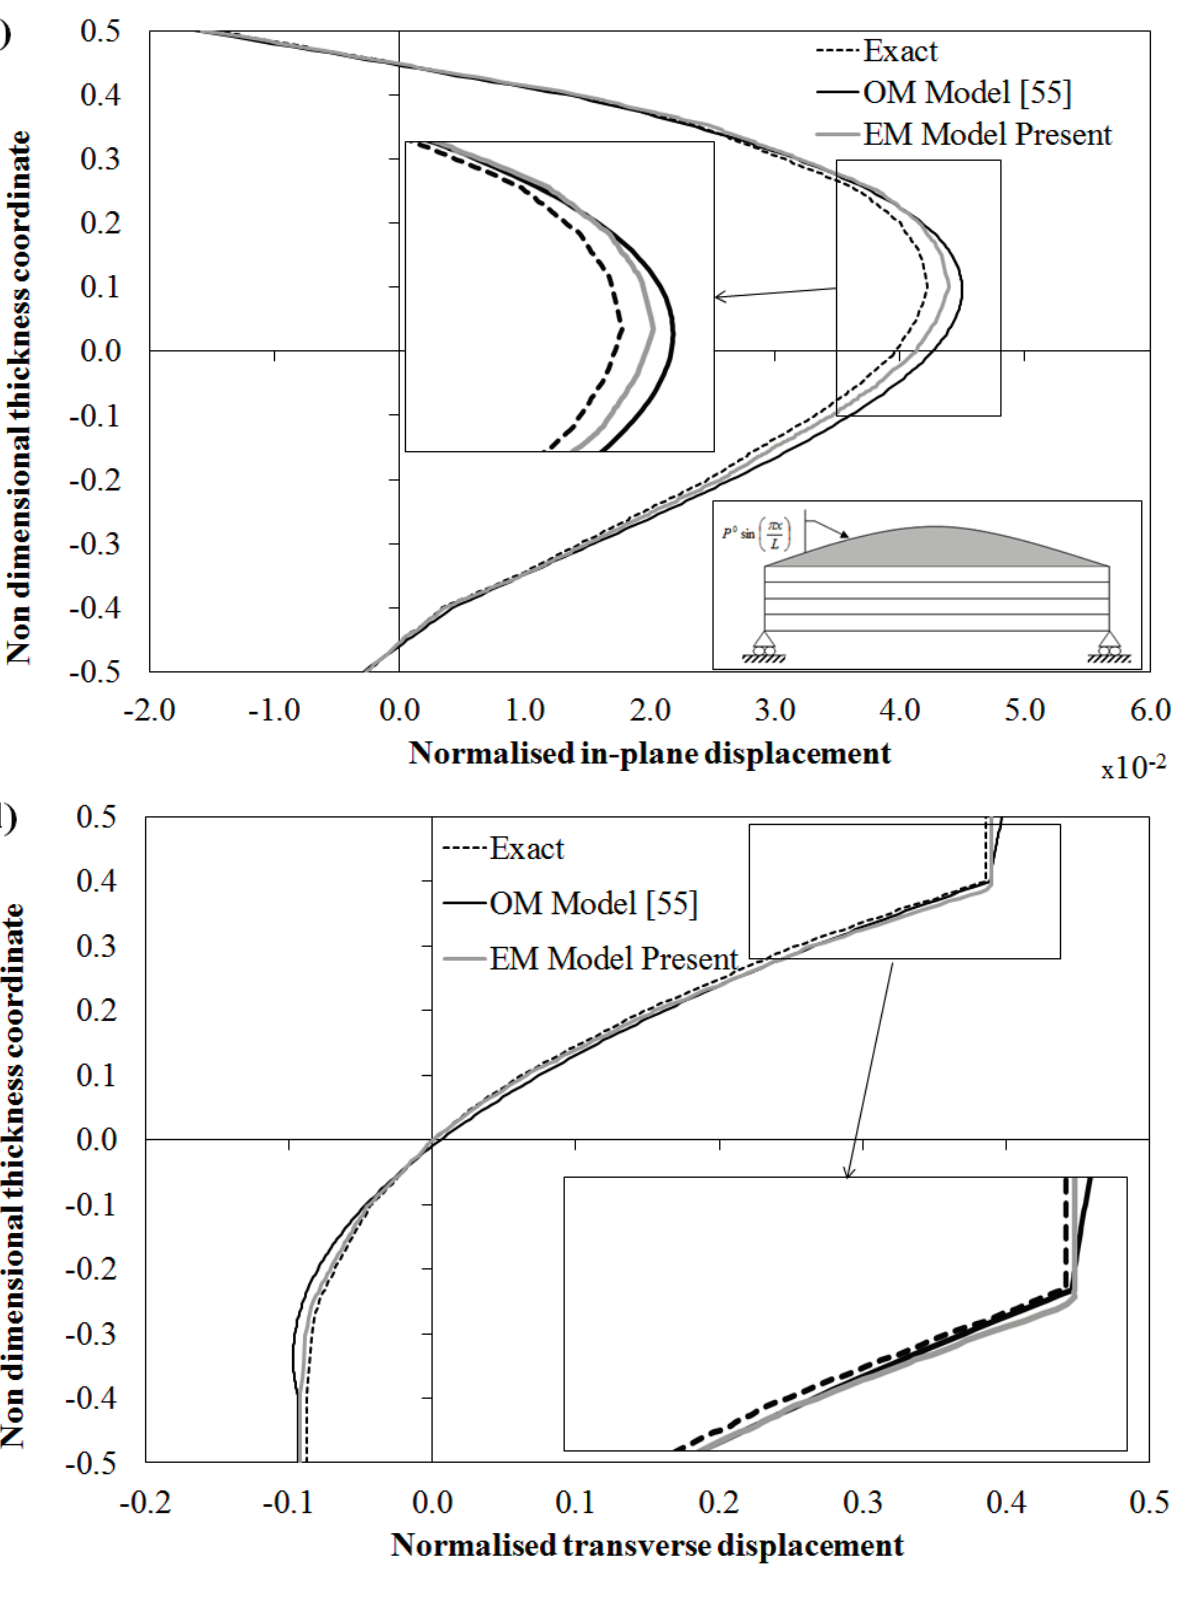
Figure 4. Exact solution and through-the-thickness distribution of: ( a ) normalized transverse shear stress; ( b ) normalized transverse stress; ( c ) normalized in-plane displacement; and ( d ) normalized transverse displacement by the OM Model [55] and by the present EM model for a sandwich beam with damaged upper